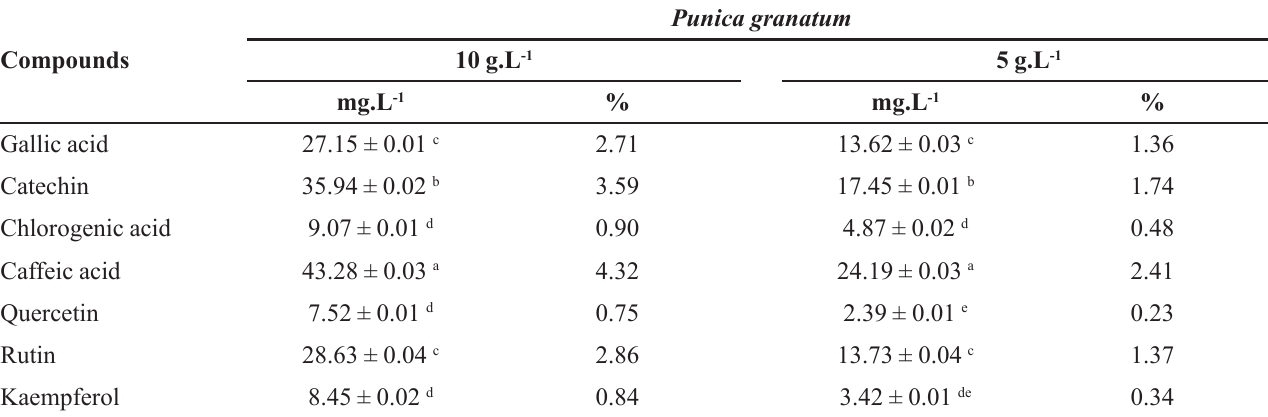
Results are expressed as mean ± standard deviation (DS) of three determinations. Columns followed by different letters differ on the Tukey test ( p <